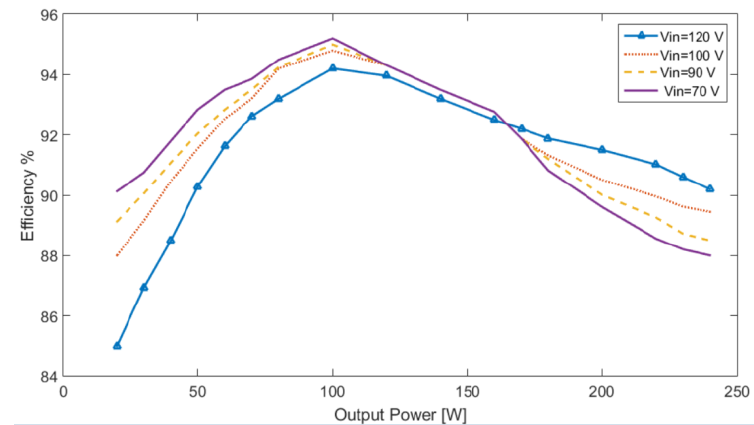
Figure 12. Measured output power at different input voltages.